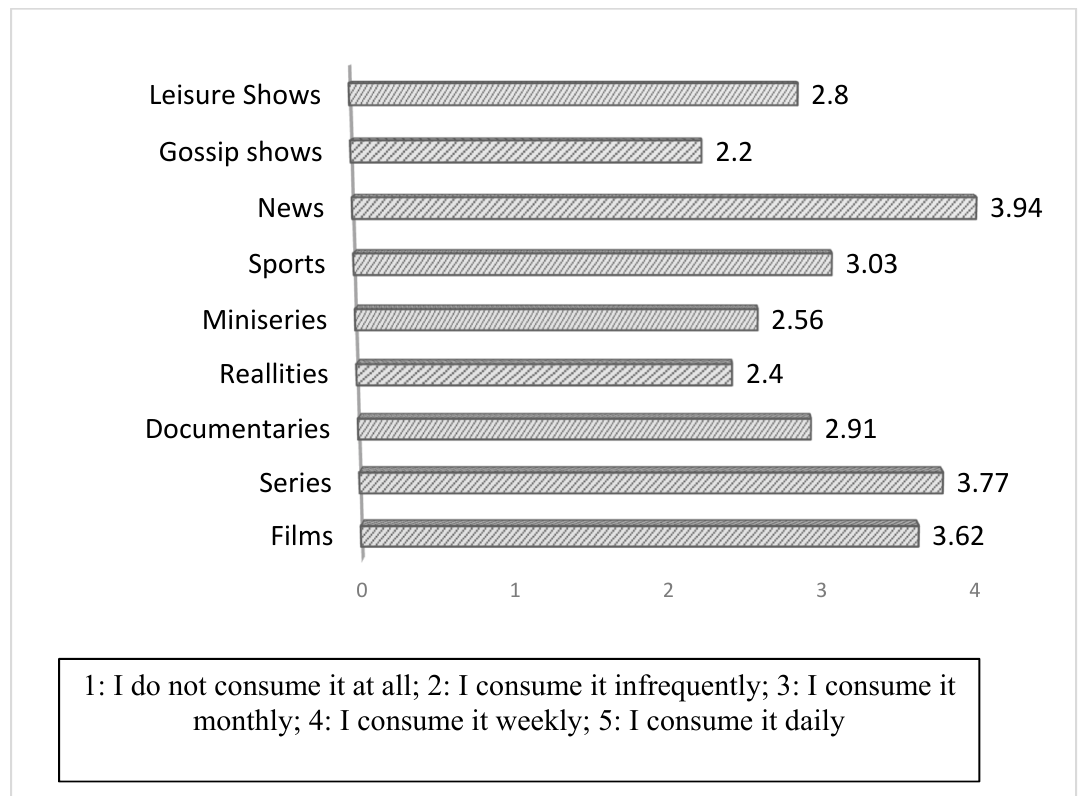
Figure 1. Consumptions’ average of audiovisual products.